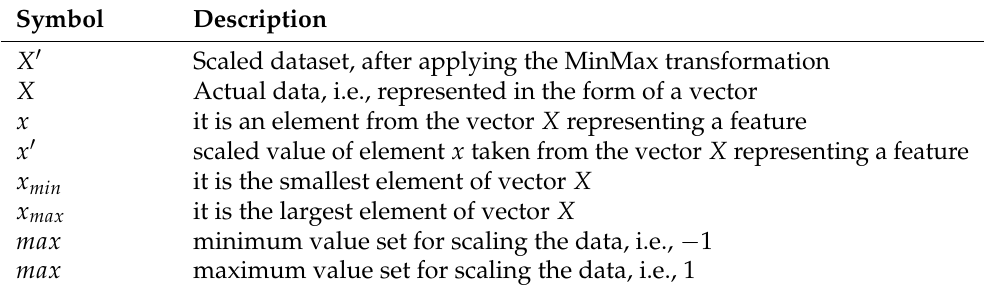
Table 1. Data and variables used in